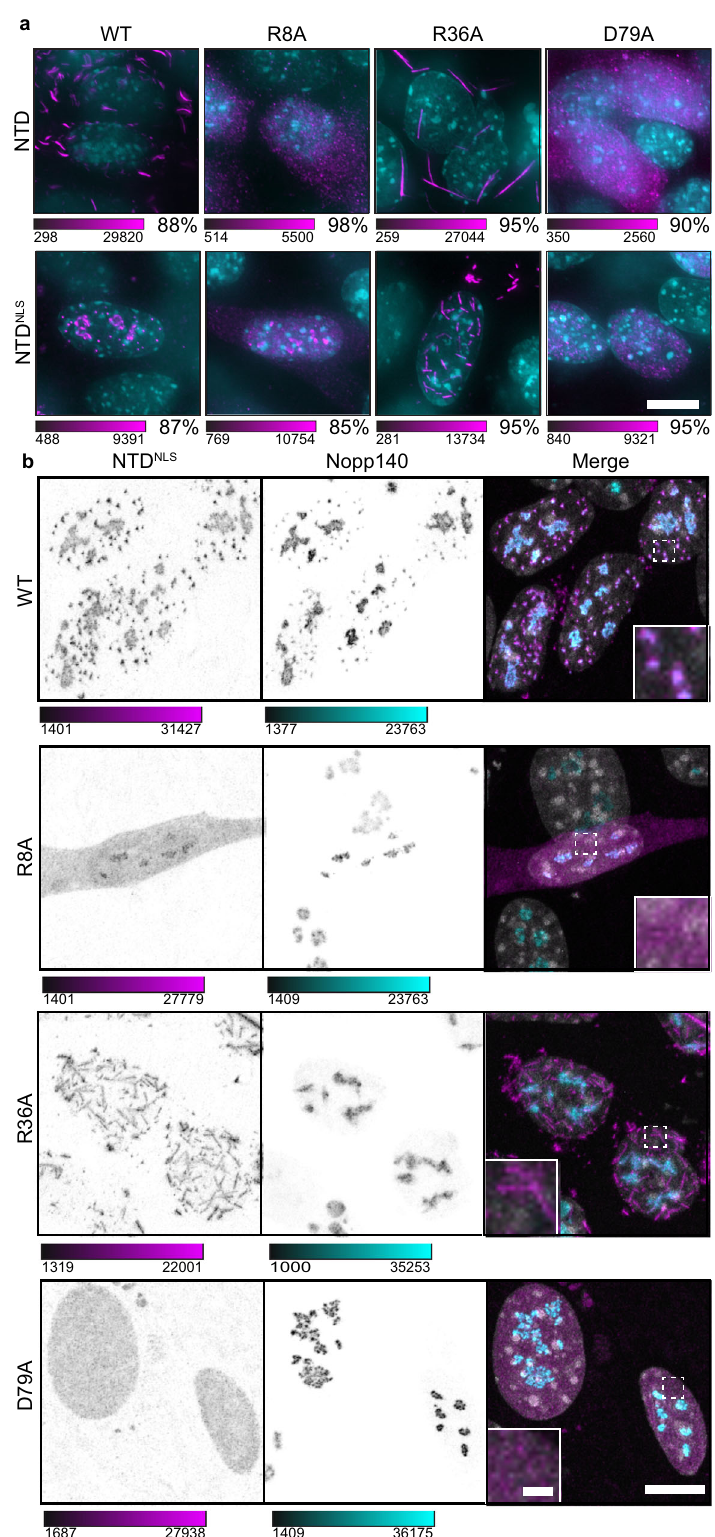
Fig. 5 | Point mutations alter NTD capacity to form fi brils and puncta. a Coil − / − MEFs transfected with constructs for cytoplasmic expression (NTD) or for nuclear expression (NTD NLS ) of the coilin NTD bearing selected point mutations. The NTD wasimmunostainedwith anti-myc(magenta)and DNAvisualizedwithDAPI (cyan). Color scale bars given in analog-digital units. Scale bar = 10 µ m. Percentage to the lower right indicates the fraction of cells with the displayed phenotype where n =300 cells. Images acquired with DeltaVision. b Coil − / − MEFs transfected with